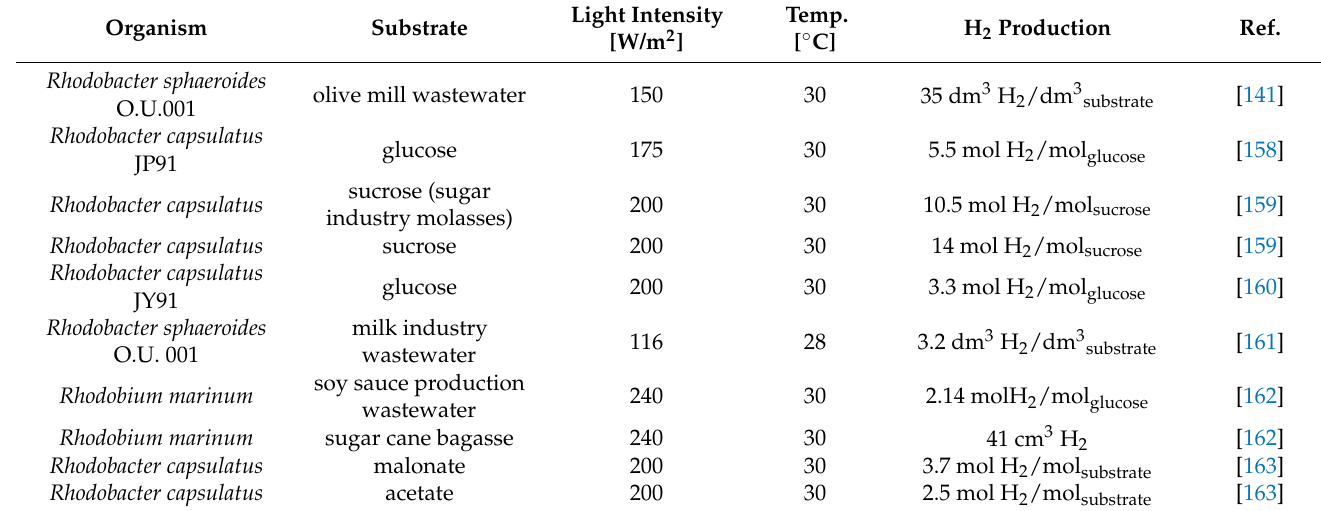
Table 2. Comparison of literature data on photofermentative hydrogen